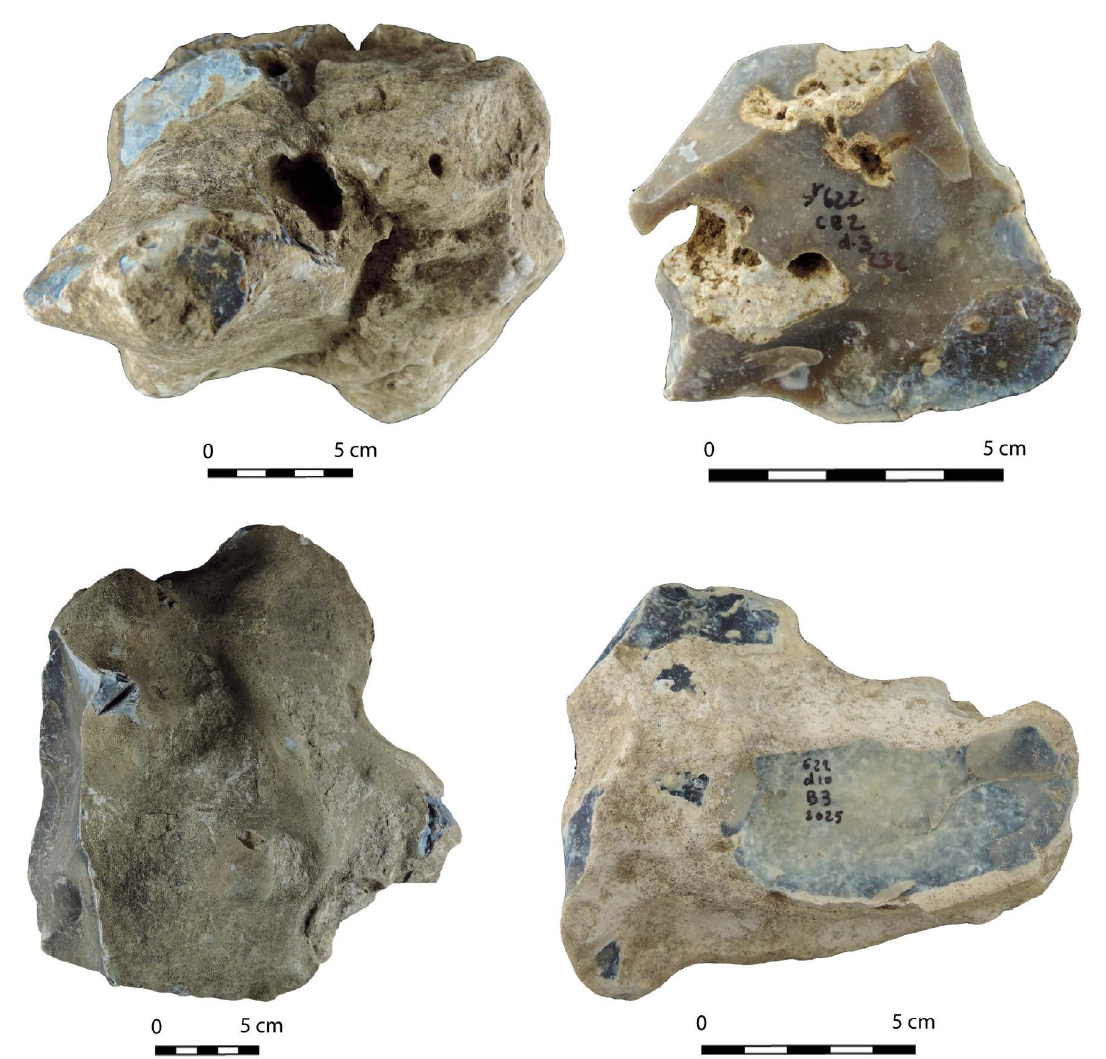
Figure 2. Exemple de matière première utilisée par les néolithiques. Photos de É. Ravon. Figure 2. Example of raw material used by the Neolithic. Photos by É.